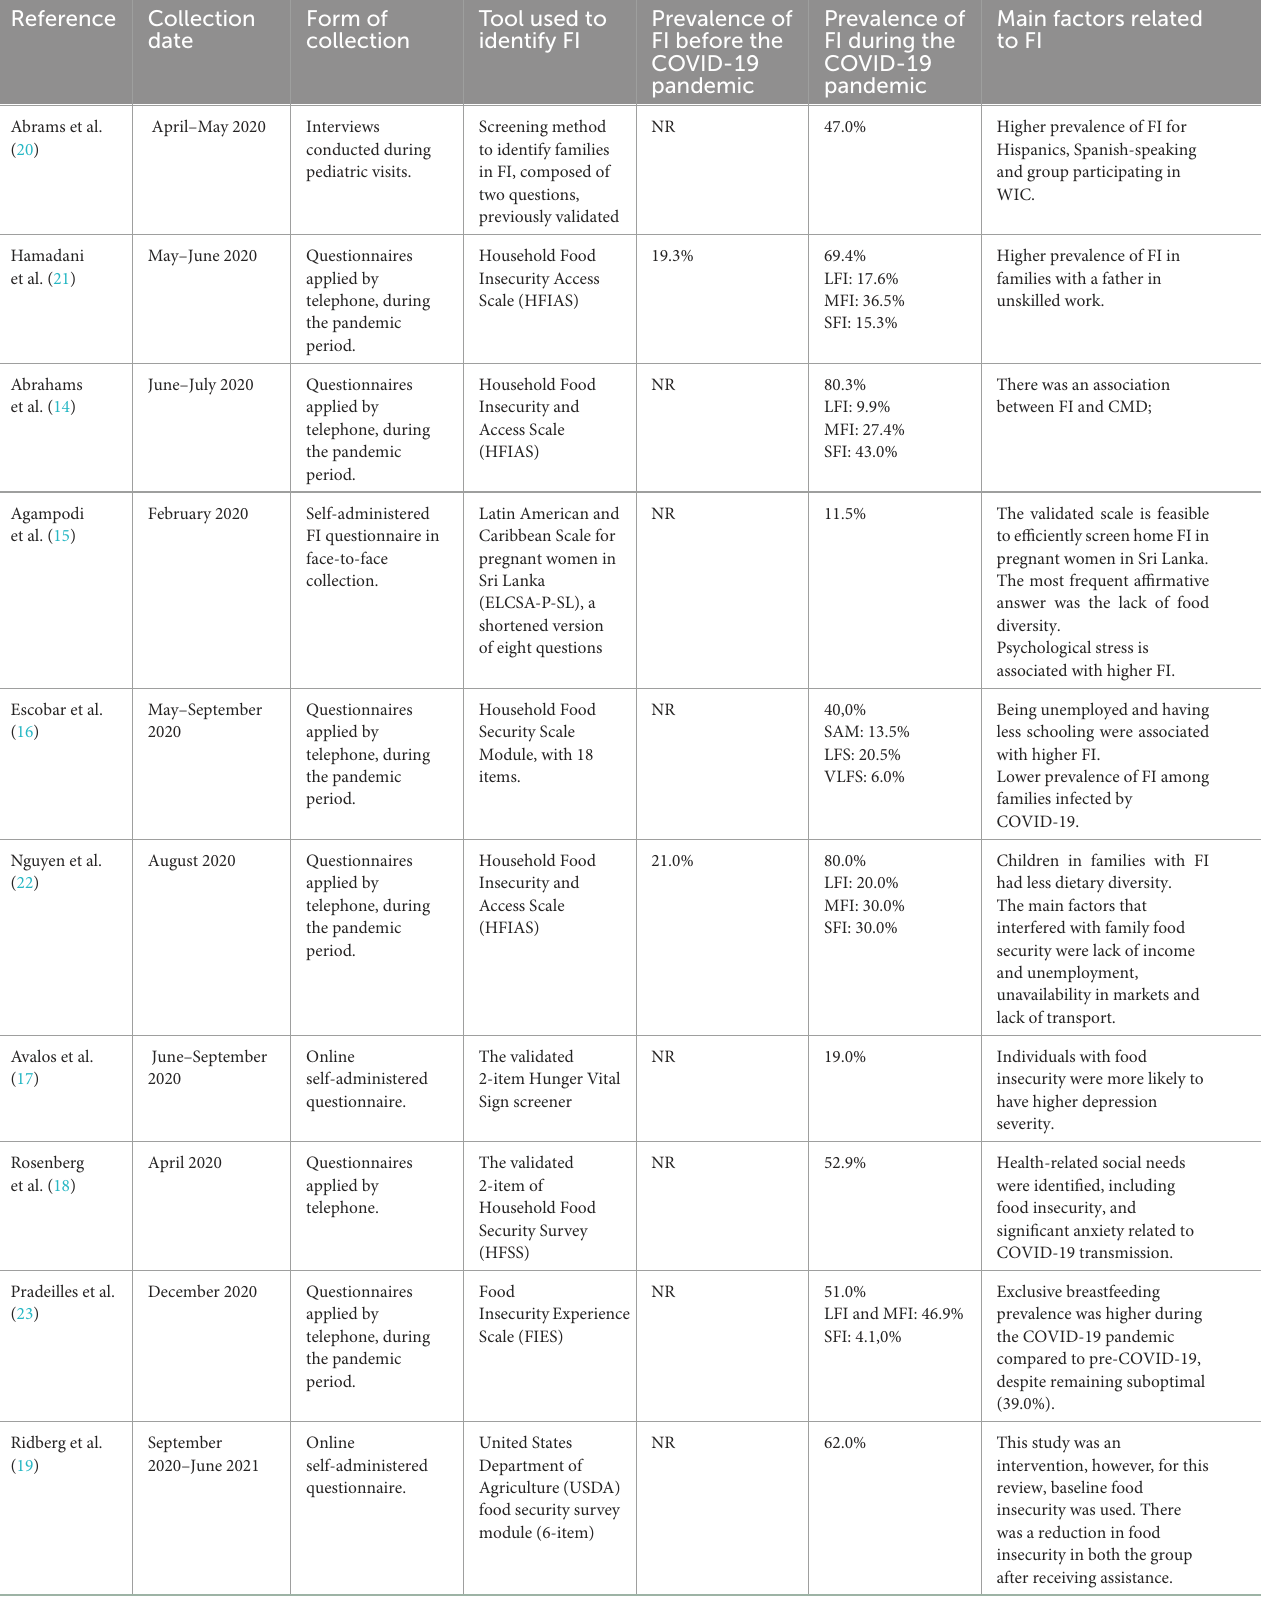
TABLE 2 Description of the methods used and main results related to Food